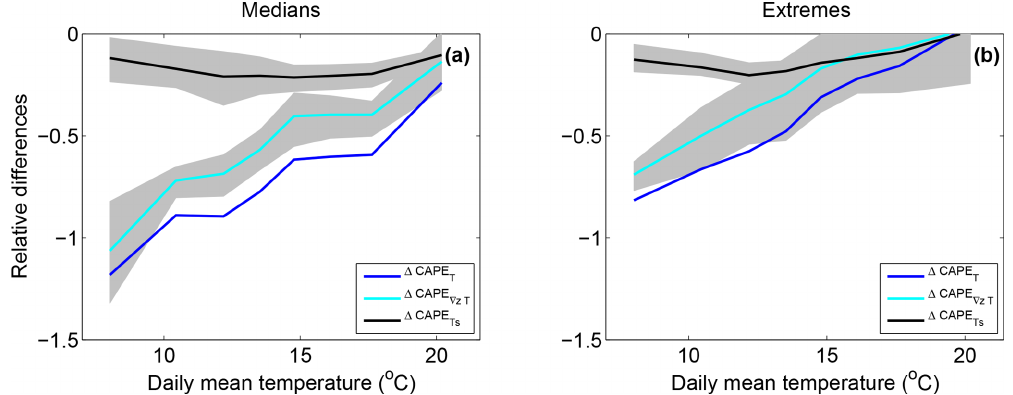
Figure 13. Temperature vertical profile contribution to the change in CAPE between the HR MAX and the HR MIN simulation for median (a) and extreme (b) precipitation events (blue, (cid:49) CAPE T ). The surface temperature contribution ( (cid:49) CAPE T temperature vertical gradient contribution ( (cid:49) CAPE ∇